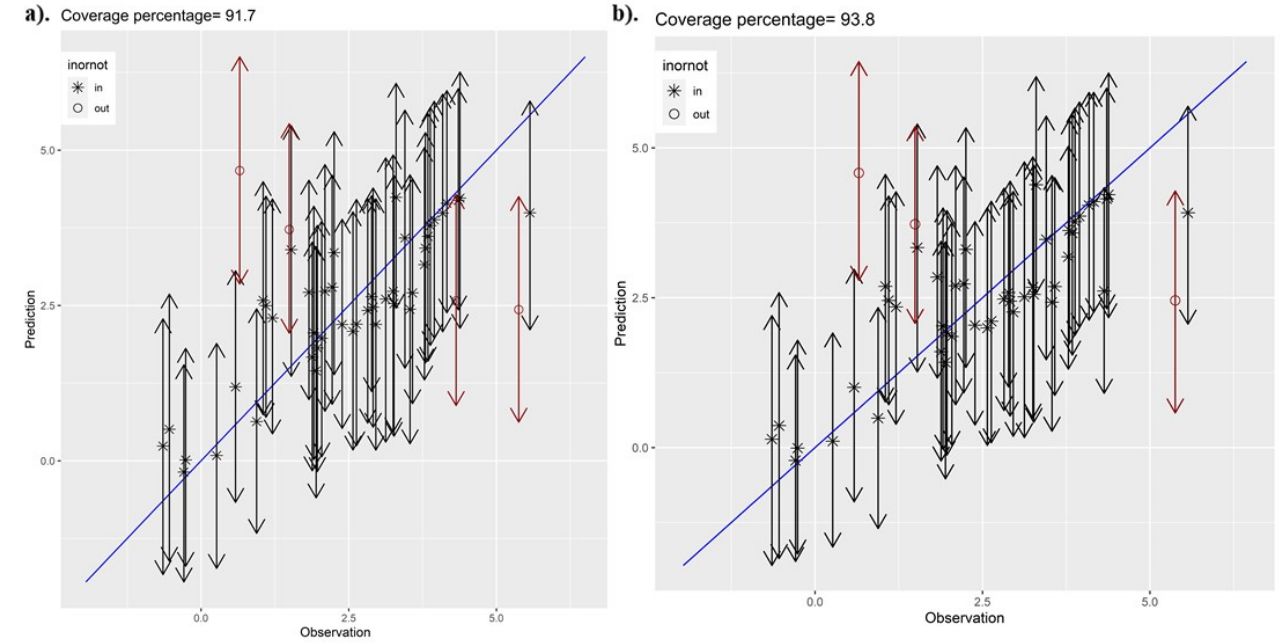
Figure 7. Landsat ‐ 8 and Sentinel ‐ 2 C stock ‐ based predictions vs. C stock observations alongside 95% Figure 7. Landsat-8 and Sentinel-2 C stock-based predictions vs. C stock observations alongside intervals. 95%